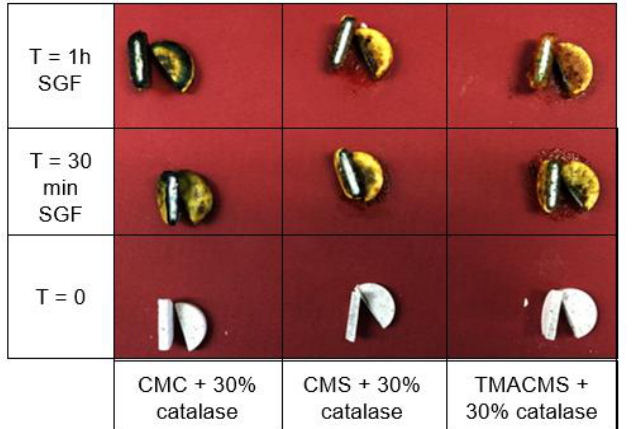
Figure 5. Cross-sectional cuts of the tablets containing a pH indicator and incubated in SGF. CMC: CarboxyMethylCellulose.